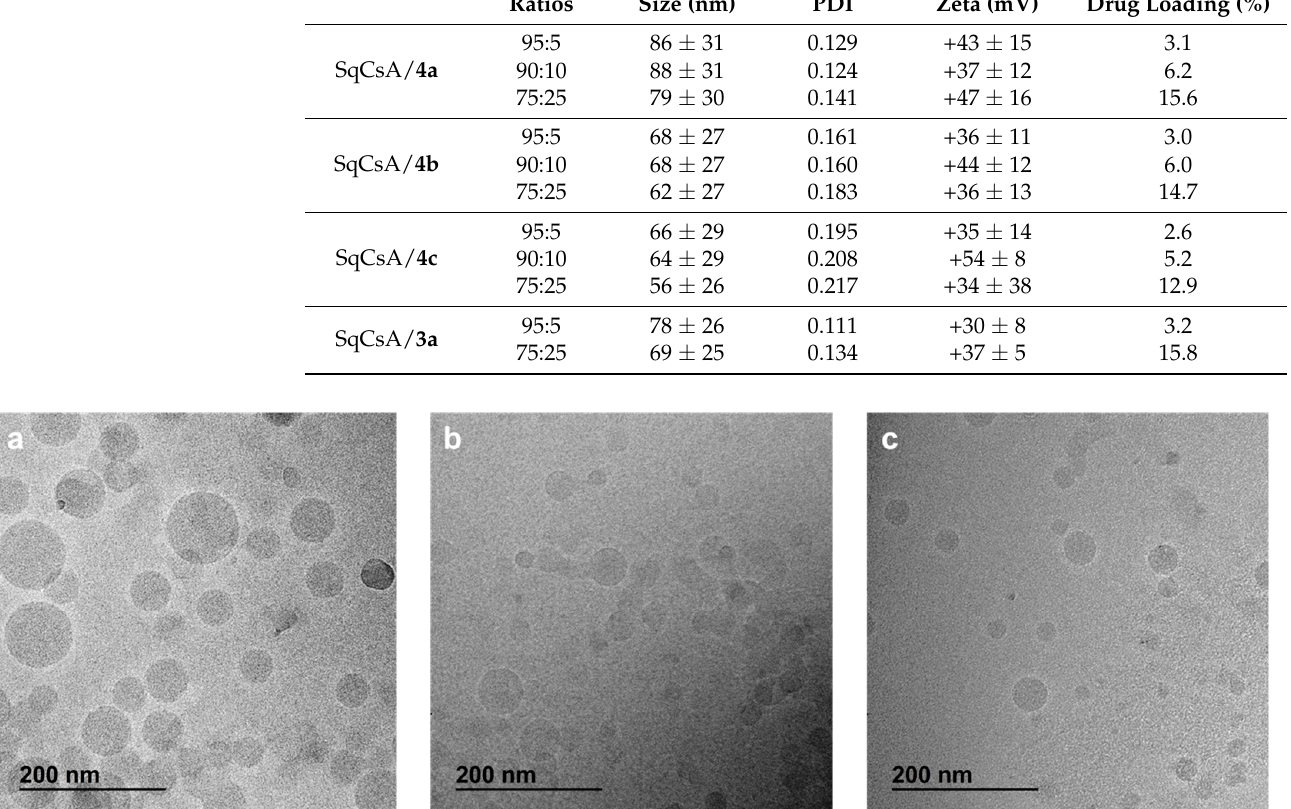
Figure 3. CryoTEM images of SqCsA/ 4a ( a ), 4b ( b ) and 4c ( c ) NPs.